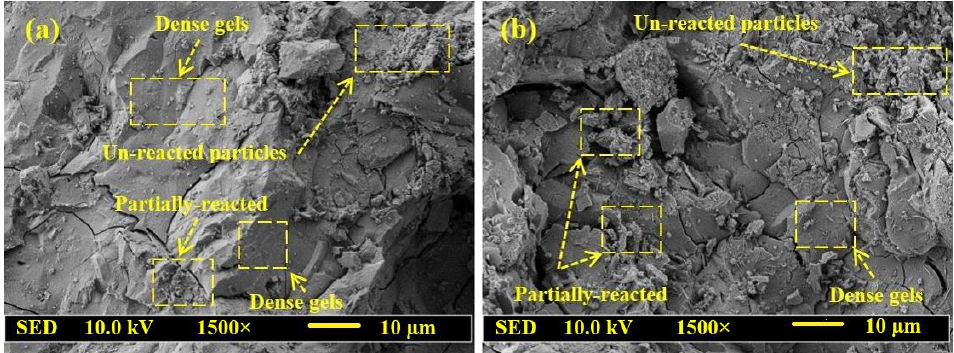
Figure 4. SEM images of GPMs at 28 days of curing age containing ( a ) 50% WCT and ( b ) 70% WCT.